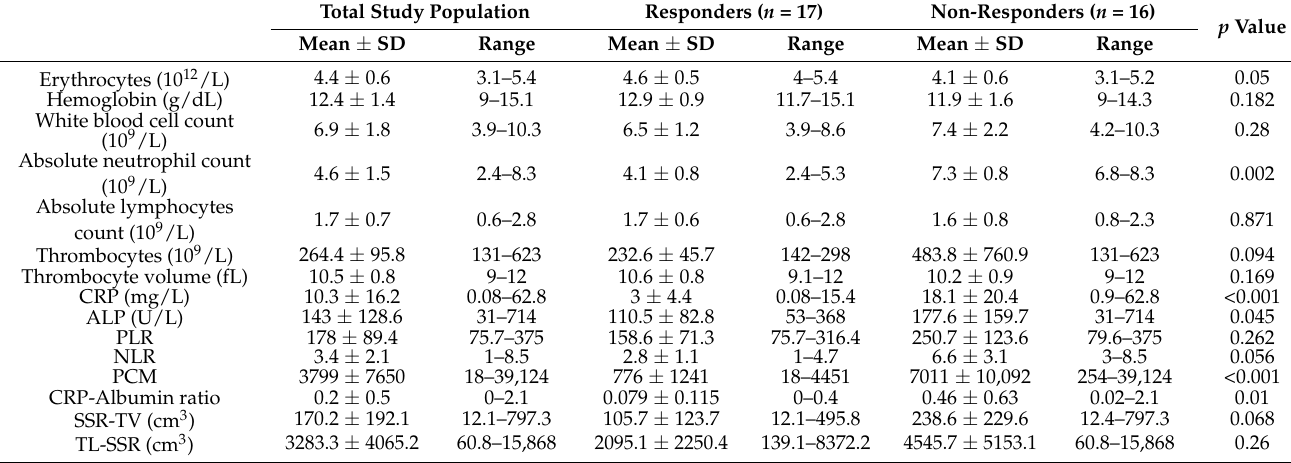
Table 2. Assessment of prognostic value of blood-based parameters for response prediction.